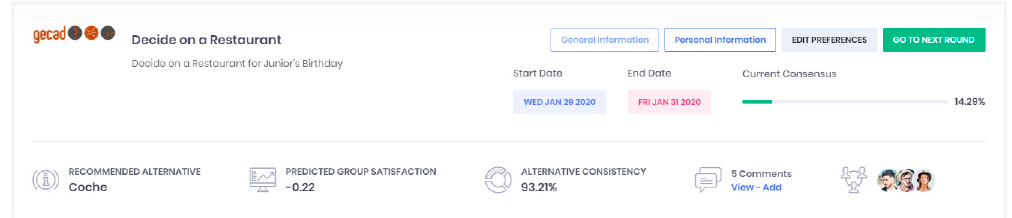
Figure 2. The top of the dashboard presented to each decision-maker.